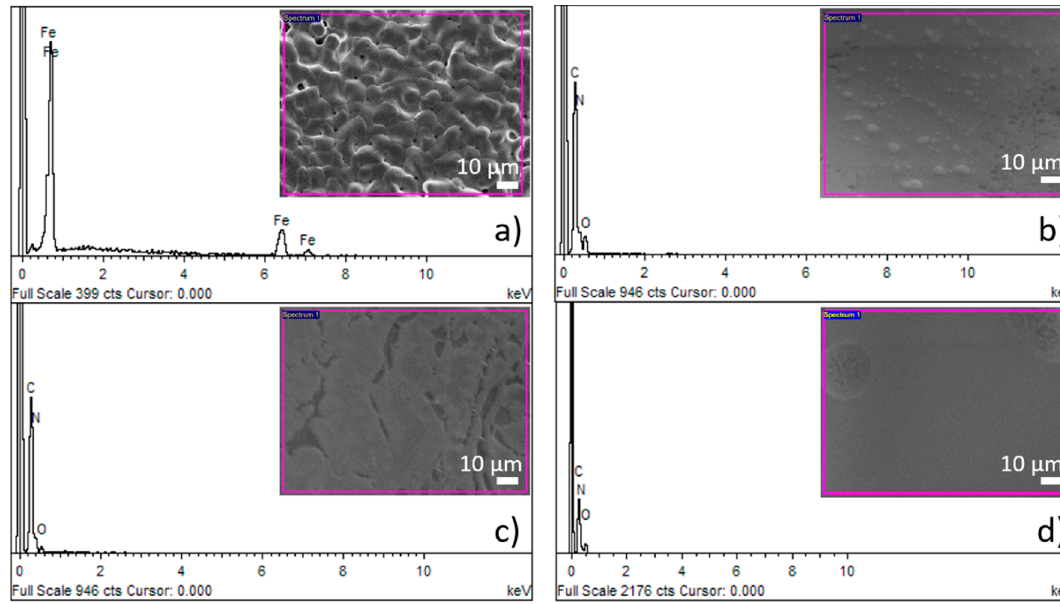
Table 1. Average weight (mg) and content (wt %) of polyethyleneimine (PEI) coating deposited on the surface of the iron foams. Figure 1. ( a , b ) The scanning electron microscopy (SEM) micrographs of the sintered iron sca ff old; ( c , d ) metallographic cross-sections of the sintered iron sca ff old. Comparison of the di ff erent porosities present in the material.